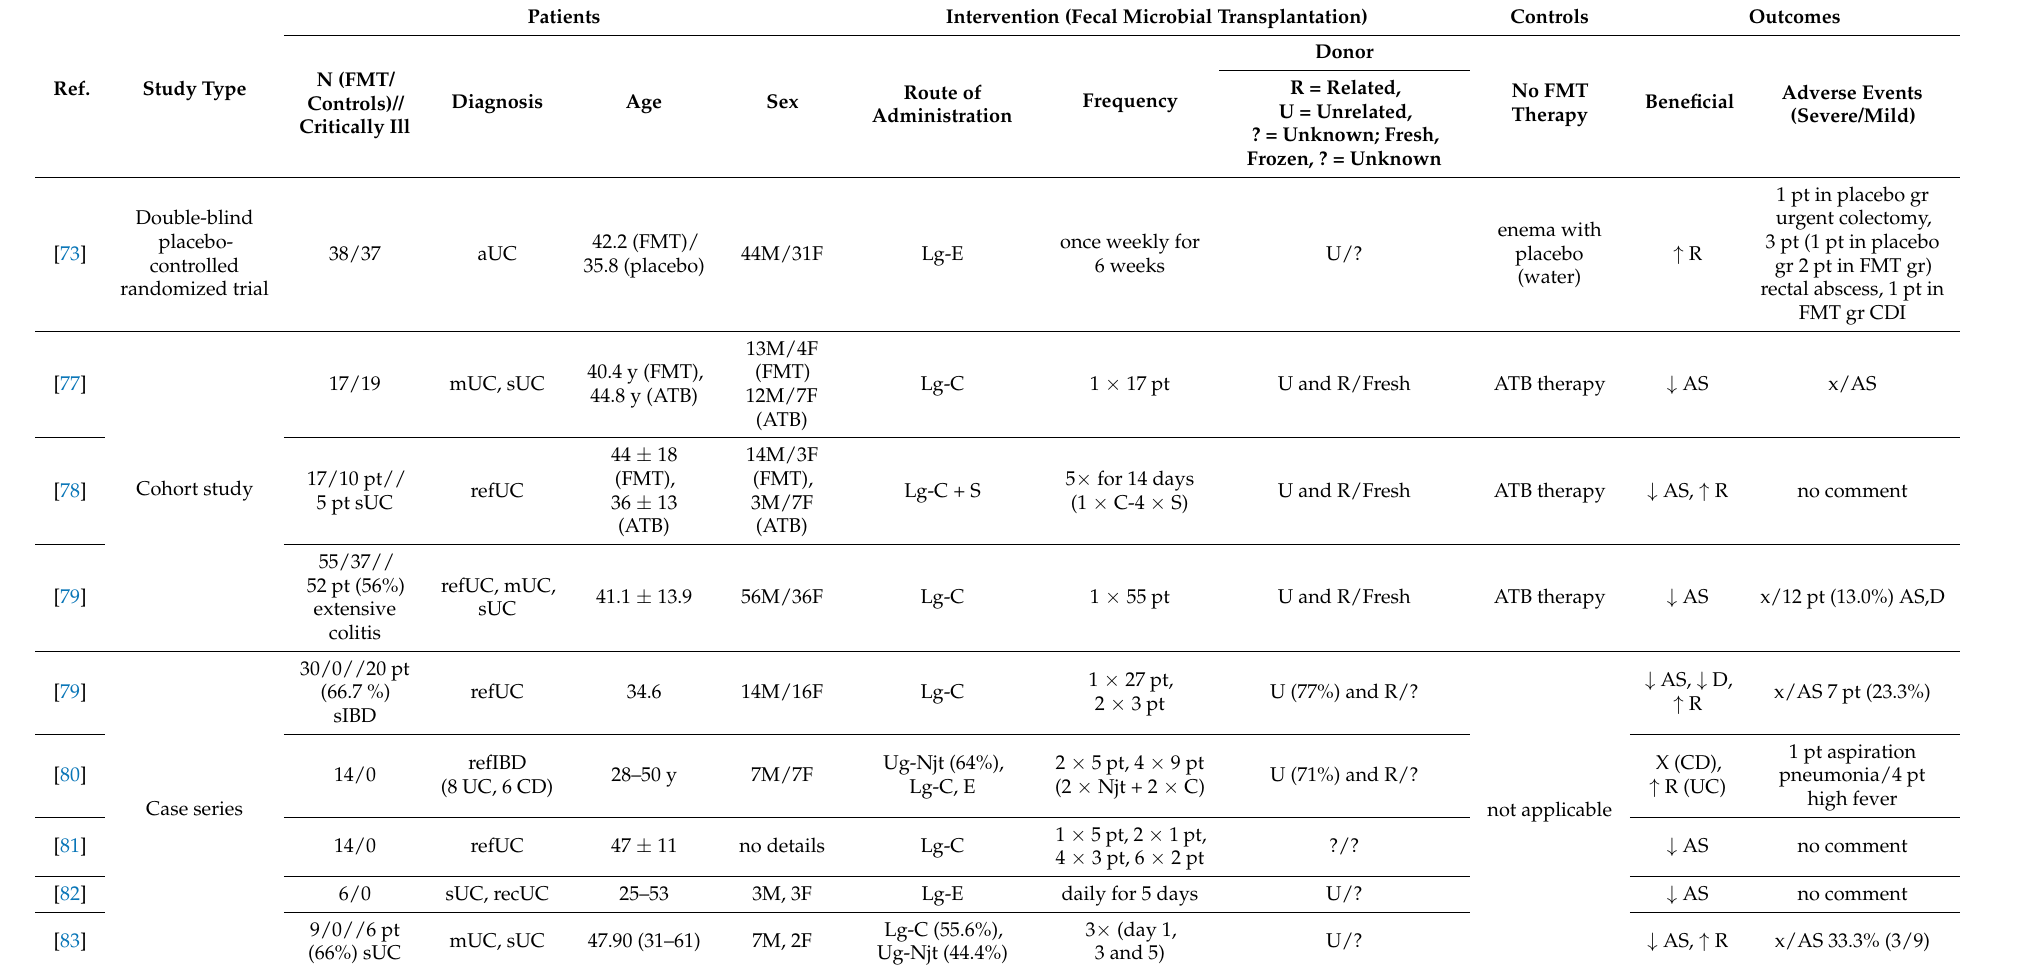
Table 2. Clinical studies on critically ill patients with inflammatory bowel